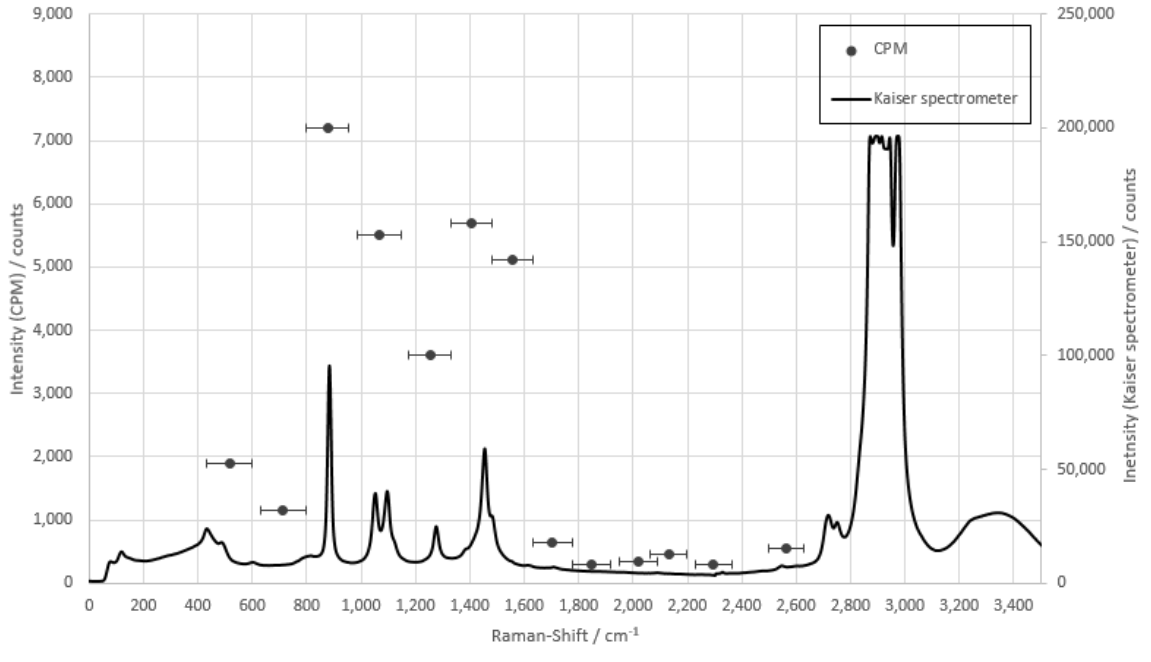
Figure 9. Comparison measurement of ethanol with the fiber array compared to the raw spectra of the Kaiser spectrometer. The integration time of the CPMS is 1 s, and the integration time of the Kaiser spectrometer is 10 s.